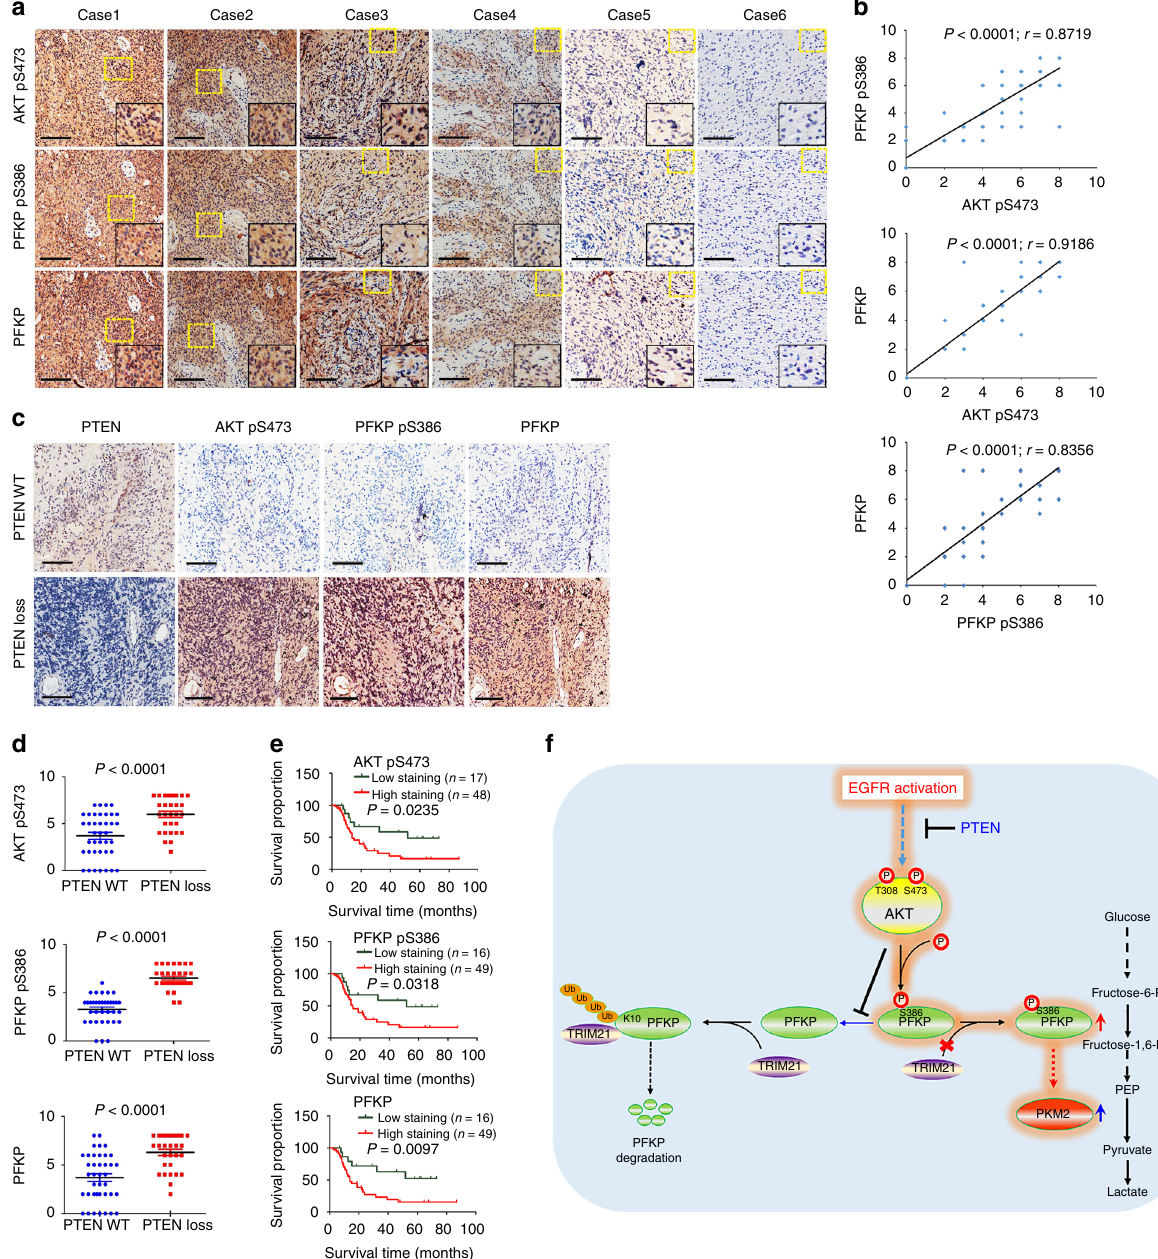
Fig. 7 PFKP S386 phosphorylation correlates with PFKP expression and AKT S473 phosphorylation in GBM specimens and with poor prognosis. a IHC staining of 65 human GBM specimens was performed with the indicated antibodies. Representative images from the staining of six different specimens are shown. High-magni fi cation images correspond to the areas marked by yellow dotted lines. Scale bar, 100 μ m. b The IHC stains were scored, and the correlation analyses were performed. Pearson correlation test was used. Note that the scores of some samples overlap. c , d The inverse correlation between PTEN and AKT pS473, PFKP pS386, or PFKP expression in human GBM specimens was analyzed. The 65 human GBM specimens were classi fi ed into 2 groups on the basis of PTEN levels (PTEN WT, n = 35; PTEN loss, n = 30). PTEN information was obtained by Sanger sequencing covering exon regions of PTEN gene or IHC staining. In IHC staining, tumors with PTEN expression less than 10% of the rate found in WT PTEN tumors were classi fi ed as having PTEN loss. Representative images ( c ) and whisker plots ( d , Student ’ s t test) are shown. Scale bar, 100 μ m. e Kaplan – Meier plots of the overall survival rates in human GBM specimens ( n = 65) in the groups with high (staining score, 4 – 8) and low (staining score, 0 – 3) expression of AKT pS473, PFKP pS386, and PFKP. The P values were calculated using the log-rank test. f A schematic of AKT-regulated PFKP phosphorylation